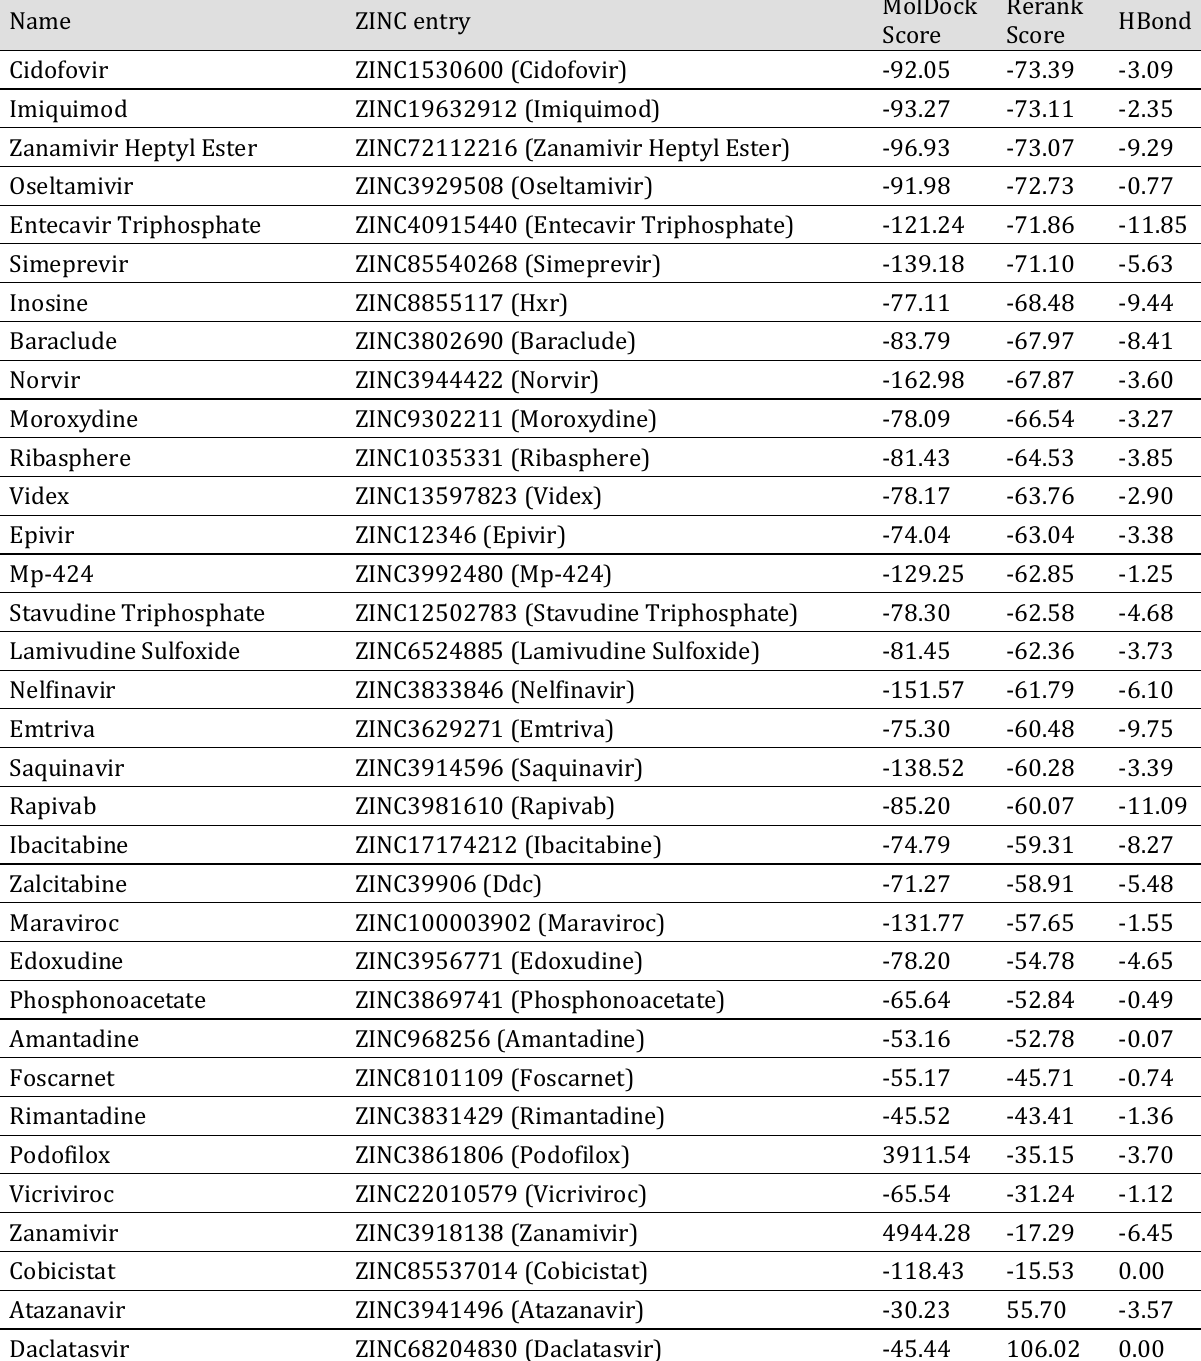
Table 2. The predicted poses scores of the rest inspected antiviral drugs